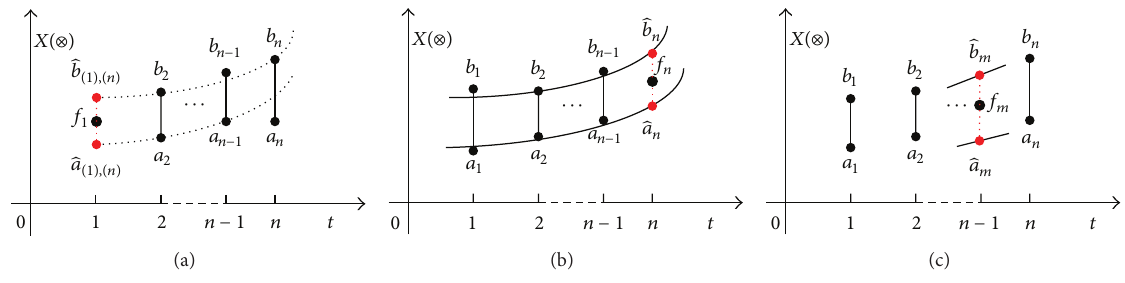
Figure 4: Sequence after boundary expansion of real